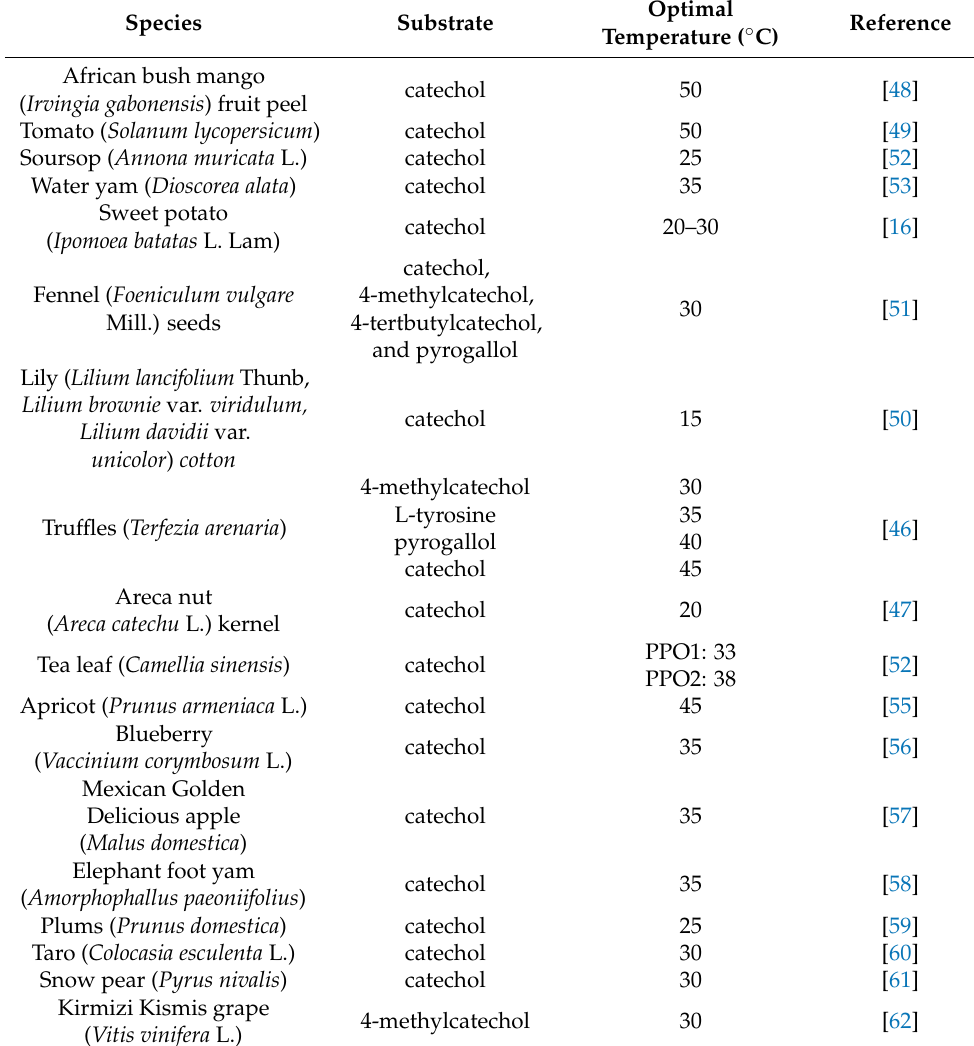
Table 2. Optimum temperature of PPO in different